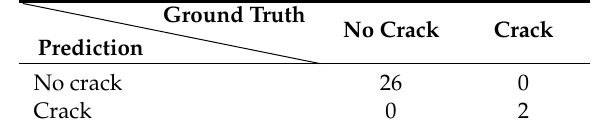
Table 4. Crack detection results (actual specimens).